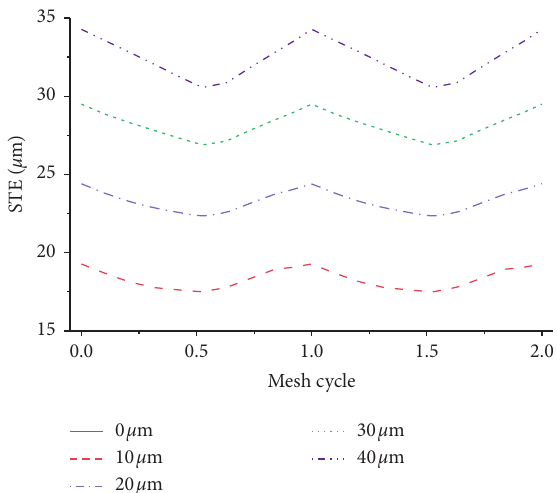
Figure 11: STE of unmodified helical gear pairs under different load conditions.